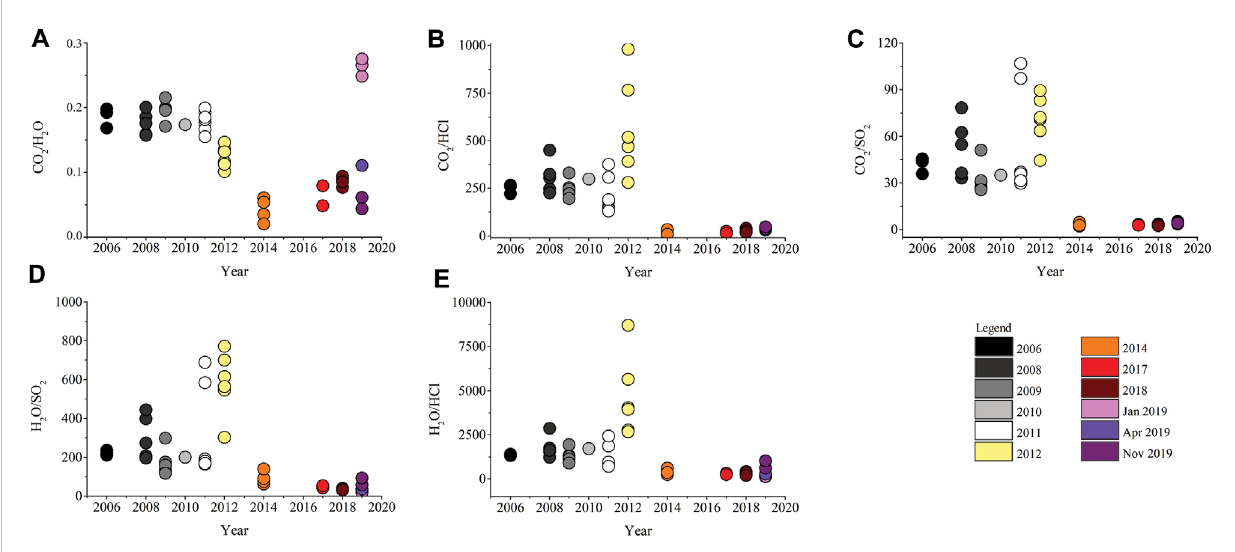
FIGURE 4 Gas ratios of Lastarria volcano fumarolic discharges (A) CO 2 /H 2 O; (B) CO 2 /HCl; (C) CO 2 /SO 2 ; (D) H 2 O/SO 2 ; (E) H 2 O/HCl. Only fumaroles with temperatures > 120 ° C were considered.